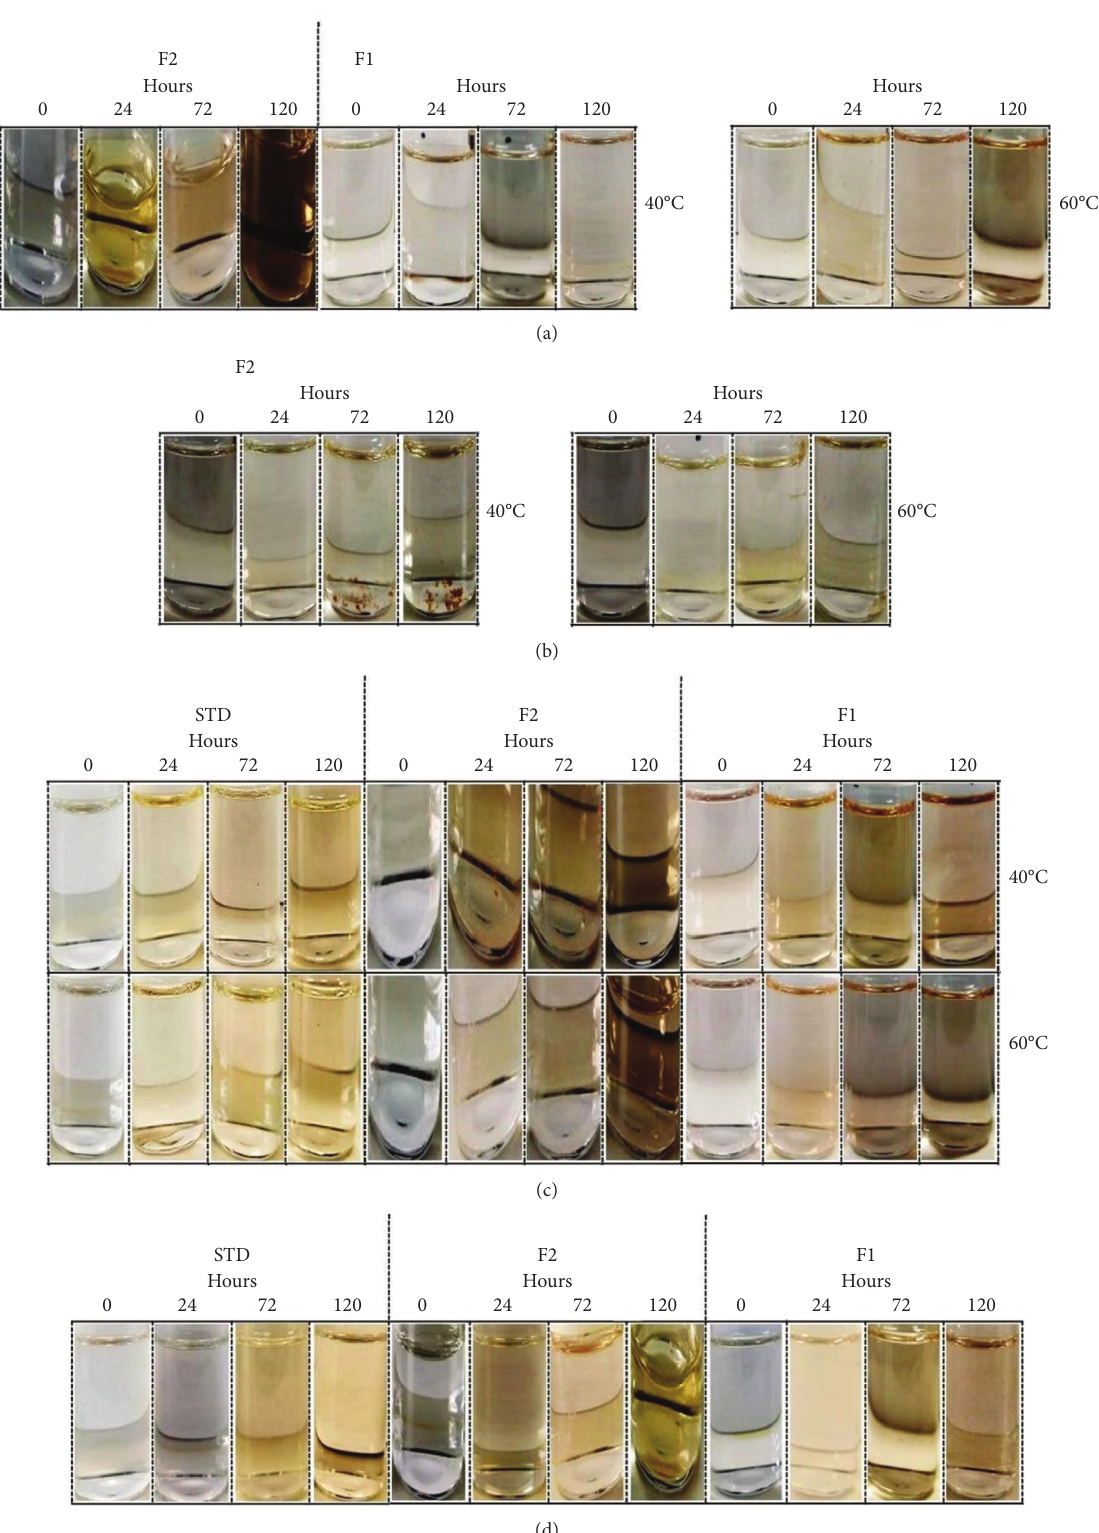
Figure 5: Colour change. Study on sample in t-RSV STD, F2, and F1 solutions subjected to forced degradation in temperature (III), acid hydrolysis (IV), basic hydrolysis (V), and exposure to photolysis with UV light at λ � 365nm (VI). Note: the solutions that did not exhibit colour changes were not included in the